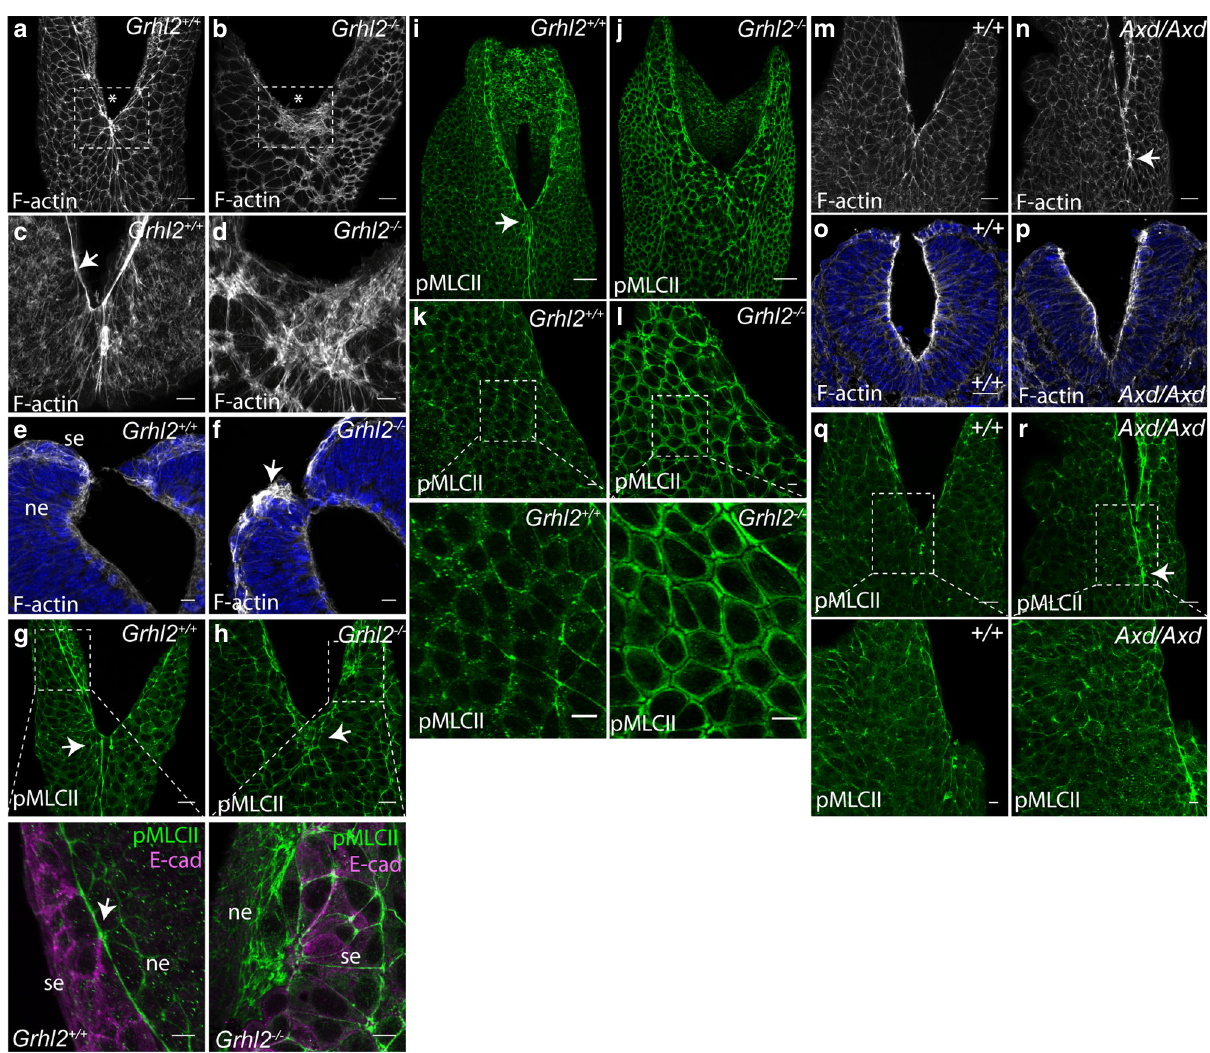
Fig. 5 Cytoskeletal abnormalities in surface ectoderm of Grhl2 mutant embryos. a , b , m , n Surface-subtracted images of dorsal view of phalloidin stained PNP regions (asterisk indicates closure point) of Grhl2 − / − and Axd/Axd mutants and equivalent wild types at E9.5. F-actin localises at cell boundaries in the surface ectoderm of wild-type controls ( a , m ), and shows profoundly disturbed organisation in Grhl2 − / − (box in b ) and greater intensity of staining in the midline in Axd/Axd (arrow in n ). c , d High-resolution images of the PNP closure point (boxed in a , b ), show enrichment in an ‘ actin cable ’ at the margins of the open neural folds in wild type (arrow in c ), which is disrupted in Grhl2 − / − ( d ). e , f , o , p Transverse sections of phalloidin (grey) stained Grhl2 − / − and Axd/Axd embryos at E9.5 (nuclei stained blue with DAPI). Disturbed F-actin organisation in the surface ectoderm at the PNP closure point in Grhl2 − / − embryos is indicated (arrow in f ). i – l Immunostaining for p-MLCII (green) at E9.5. In wild-type embryos, surface-subtracted images of dorsal views of the PNP show notable enrichment in a ‘ cable ’ at the surface ectoderm (se)/neuroepithelium (ne) boundary in the PNP (arrow in magni fi ed image in g ), as well as in the midline overlying the most recently closed neural tube (arrows in g , I ). Like F-actin, pMLCII is disorganised in Grhl2 − / − embryos at the PNP closure point (arrow in h ) and at discrete regions of the open neural folds (boxed in h ). In contrast to pMLCII localisation at cell – cell junctions in the surface ectoderm of wild-type embryos ( k , q ), pMLCII appeared uniformly distributed around the margins of surface ectoderm cells and excluded from cell – cell junctions in Grhl2 − / − embryos ( l ). m – r The localisation of F-actin ( m – p ) and pMLCII ( q , r ) in Axd/Axd was comparable to wild-type embryos at E9.5 but consistently exhibited greater intensity of staining in the midline (arrows in n and r ). Scale bars: 10 μ m in c , d , k , l and magni fi ed areas of g – h , k – l , q , r ; 25 μ m in a , b , g , h , m , n , q , r ; 50 μ m in i , j . Images are representative of a minimum of three embryos per tension and/or that the abnormal surface ectoderm is less able to resist retraction of the neuroepithelium resulting from ‘ anti-clo- sure ’ forces in the neural folds. In contrast, average displacement of the neural folds in Axd/Axd embryos did not differ from wild- leads to lateral displacement of the neural folds 33 . In order to test type embryos and the maximal recoil observed was lower than in other genotypes (Fig. 8c, d). at E9.5. Retraction of the neural folds was signi fi cantly greater in Grhl2 − / − embryos than in wild-type littermates (Fig. 8a, b). These fi ndings indicate that the closure point is under greater lateral